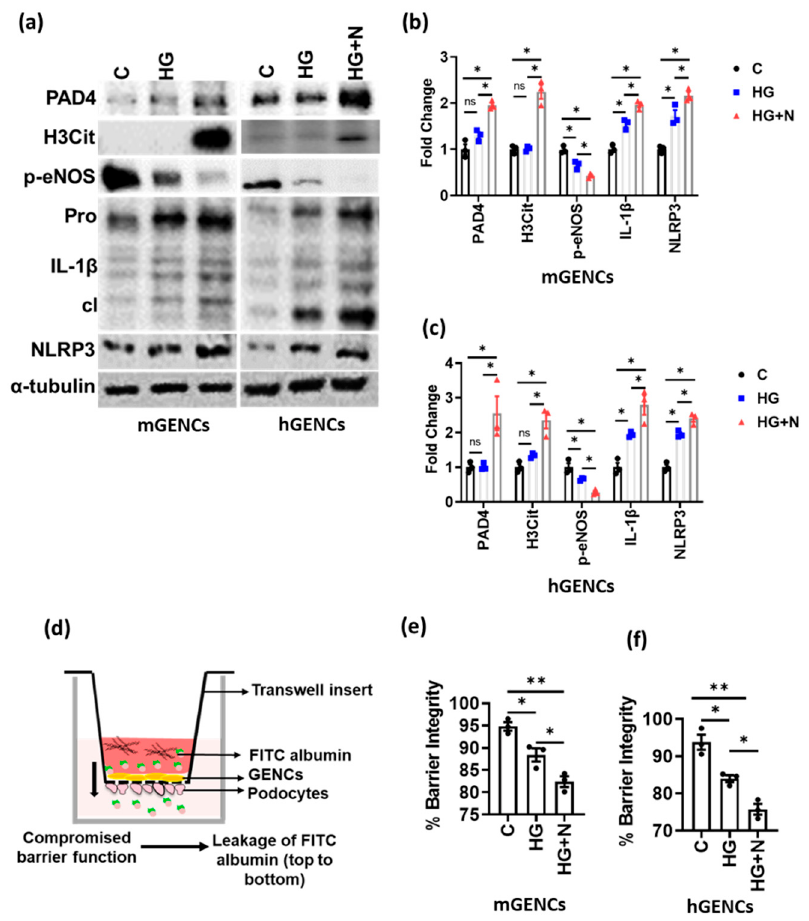
Figure 2. Neutrophils promote inflammasome activation and endothelial dysfunction. ( a , b ) Immunoblots (( a ), representative blots; ( b ), bar graph summarizing results) reflecting NET markers (PAD4, H3Cit), inflammasome activation (IL-1 β : cleaved form—cl, inactive preform—Pro; NLRP3) and endothelial function (p ‐ eNOS) in mouse (mGENCs) and ( c ) human (hGENCs) glomerular endothelial cells upon exposure to high glucose and neutrophils (HG+N) compared to high glucose alone (HG, 25 mM) or control (C, PBS). ( d ) Graphical presentation of the Boyden chamber setup for glomerular filtration barrier (GFB) assays where FITC (Fluorescein ‐ 5 ‐ isothiocyanate) Albumin is used to measure the disruption of GFB. ( e , f ) Bar graphs quantifying GFB disruption (reduced barrier integrity) in mGENCs ( e ) and hGENCs ( f ) exposed to high glucose and neutrophils (HG+N) compared to high glucose (HG) alone or control (C, PBS). N = 3 independent repeat experiments, each dot represents one independent experiment; * p < 0.05, ** p < 0.01, ns: non ‐ significant, ANOVA.